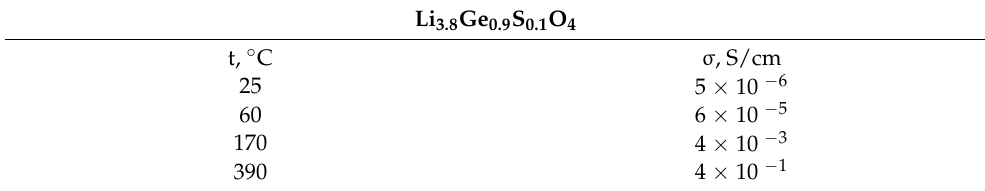
Table 1. Specific electrical conductivity of a solid electrolyte Li 3.8 Ge 0.9 S 0.1 O 4